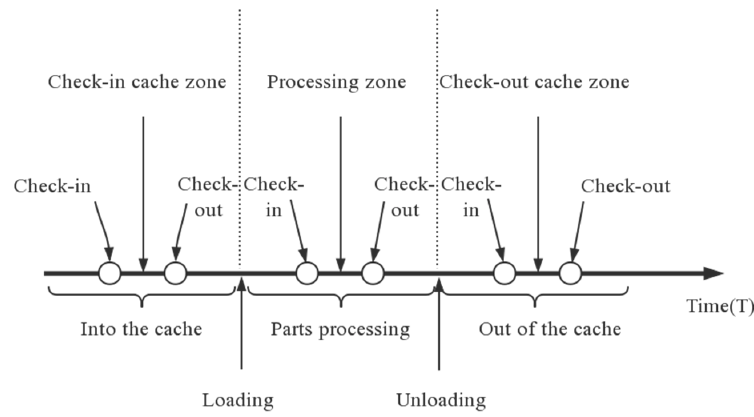
Figure 3. Outsourcing company A, B production process sequence diagram.